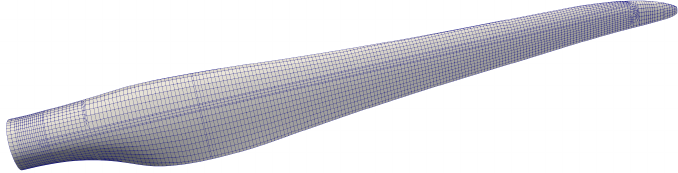
Figure 5. Finite element model of the 20m rotor